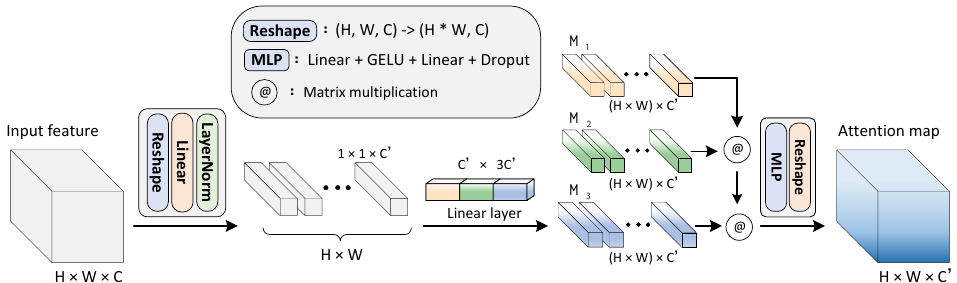
Figure 1. Diagram of the global attention